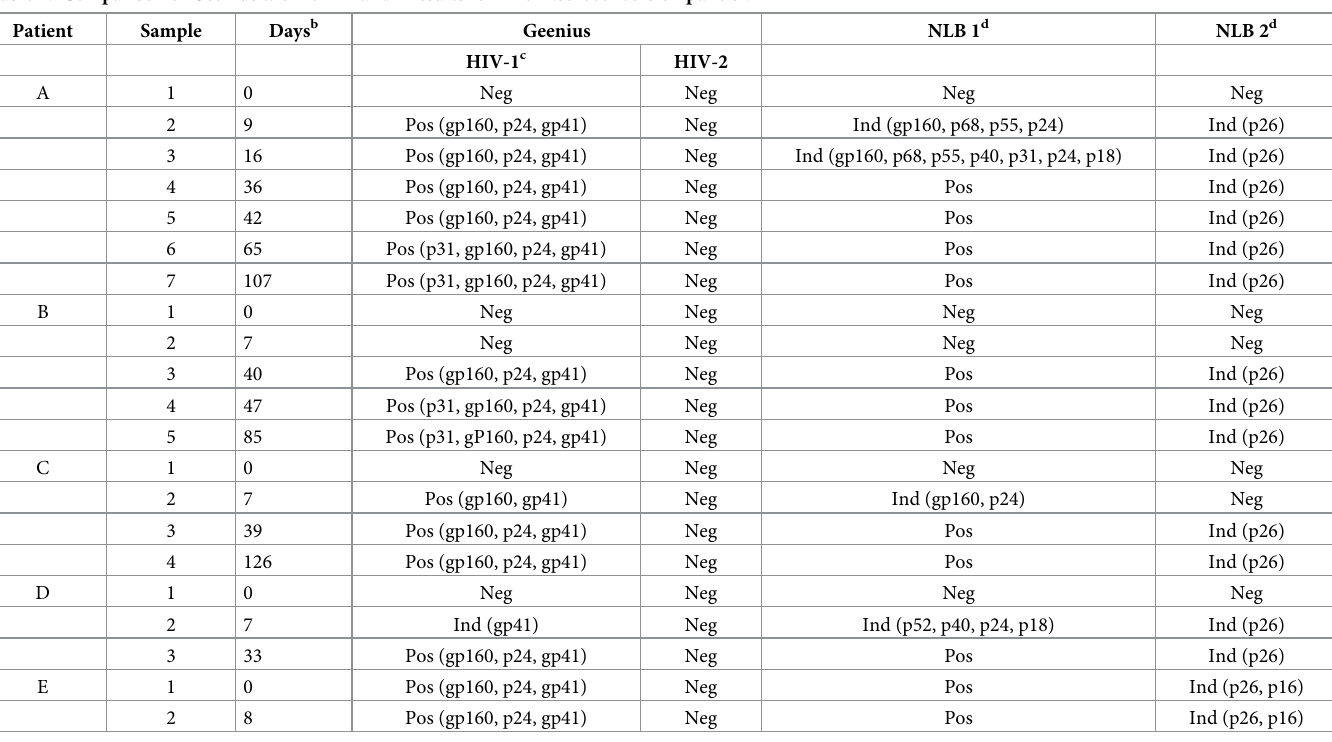
Table 2. Comparison of Geenius with NLB 1 and 2 results for HIV-1.seroconversion panels a . Patient Sample